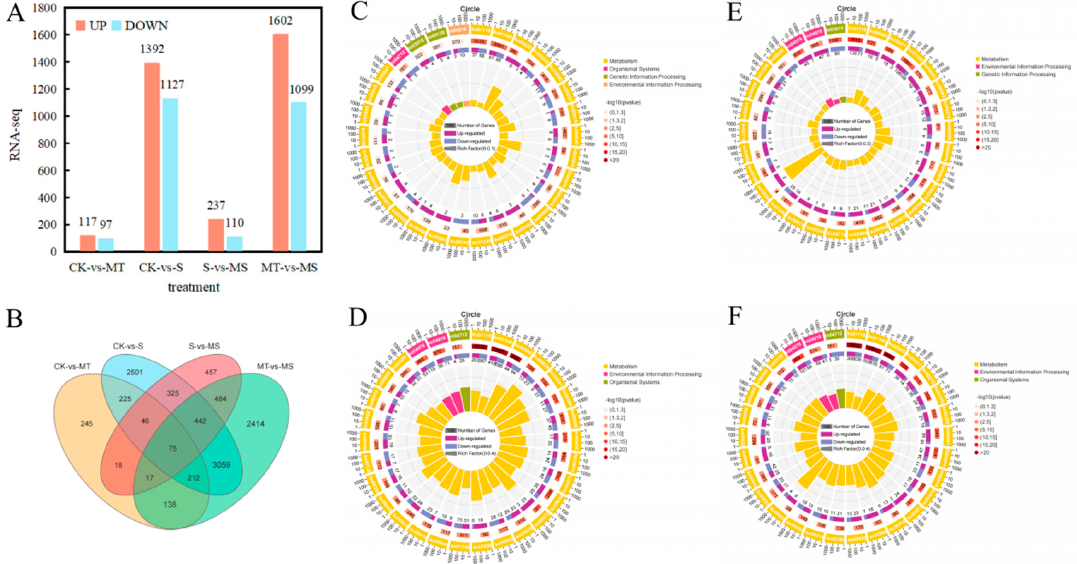
Figure 8. RNA-seq data analysis of roots in cotton seedlings under different treatments: ( A ) the number of differentially expressed genes (DEGs) in the CK vs. S, CK vs. MT, S vs. MS and MT vs. MS comparisons; ( B ) Venn diagram of DEGs; summary of Kyoto Encyclopedia of Genes and Genomes (KEGG) categories of DEGs in ( C ) CK vs. MT, ( D ) CK vs. S, ( E ) S vs. MS and ( F ) MT vs. MS comparisons. CK, control treatment; S, NaCl treatment; MT, melatonin treatment; MS, combined NaCl and melatonin treatment.